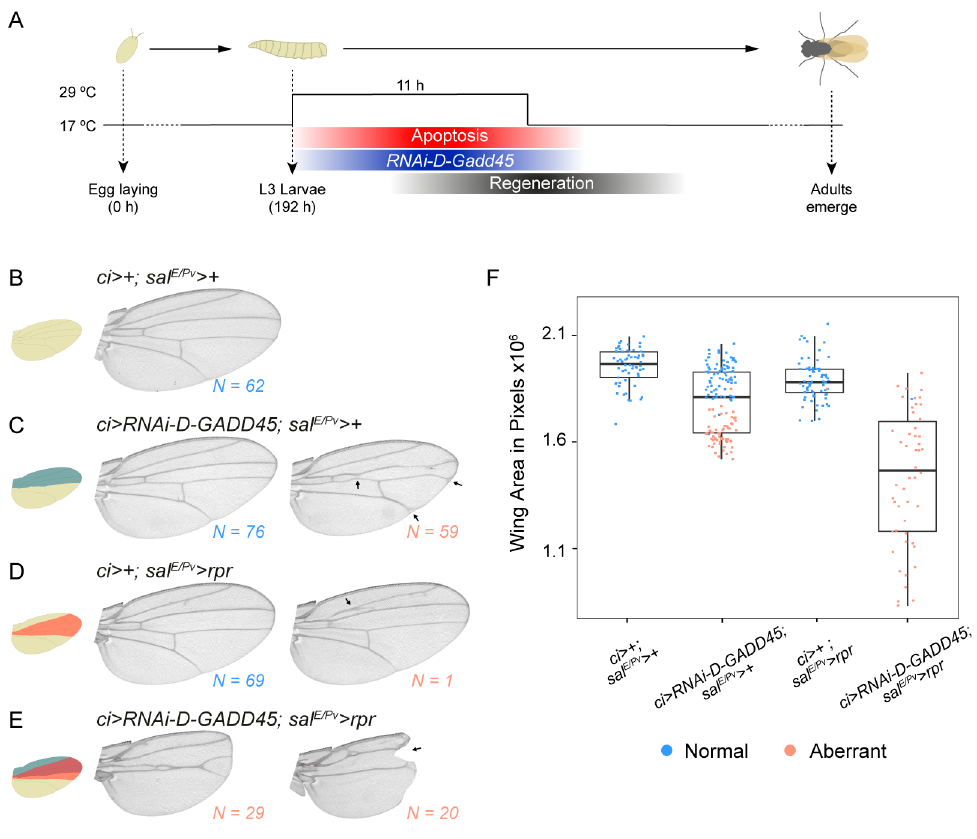
Figure 5. Depletion of D-GADD45 severely impairs wing regeneration. ( A ) Schematic representation of the regeneration model used. ( B – E ) Adult wings showing the predominant phenotypes observed in each condition. Number of wings analyzed is indicated for each condition. ( F ) Box plot showing the average area of adult wings after 11 h of induction. Each dot represents one wing; wild-type pattern (blue) and aberrant pattern